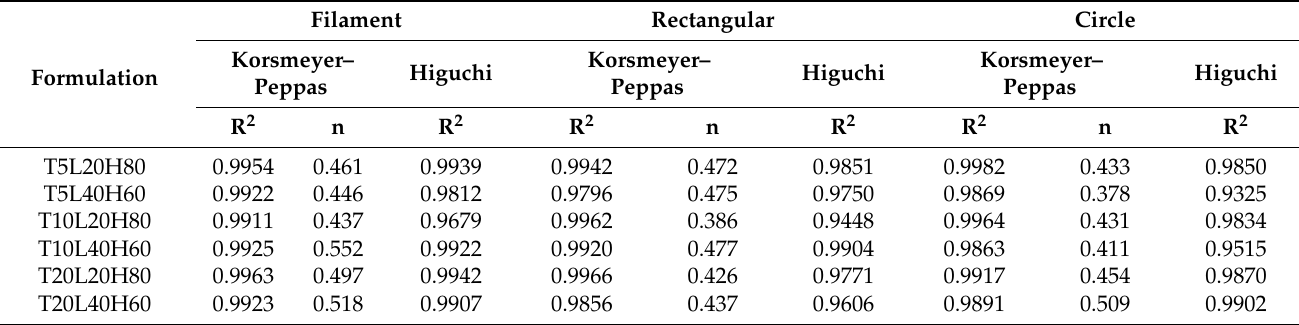
Table 3. Data obtained after fitting TA release curves to Korsmeyer–Peppas and Higuchi